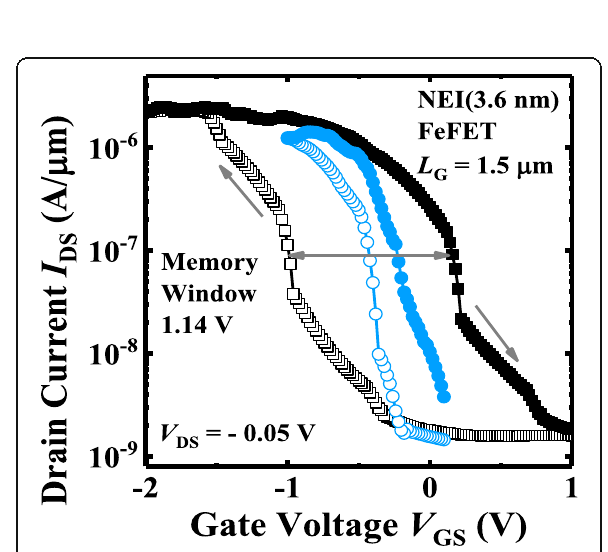
Fig. 10 For a large V GS DC sweeping range, a MW of 1.14 V is observed for the NEI (3.6 nm)